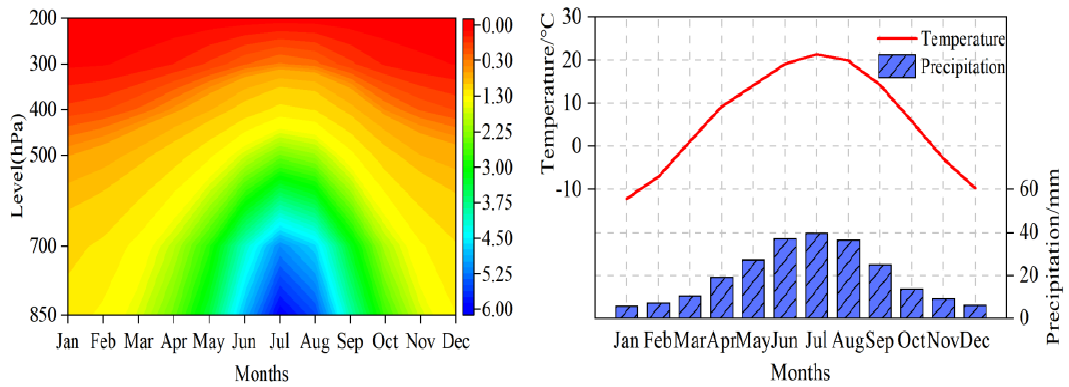
Figure 4. Level-month profile of annual specific humidity and monthly average temperature and precipitation during the period 1980–2018.